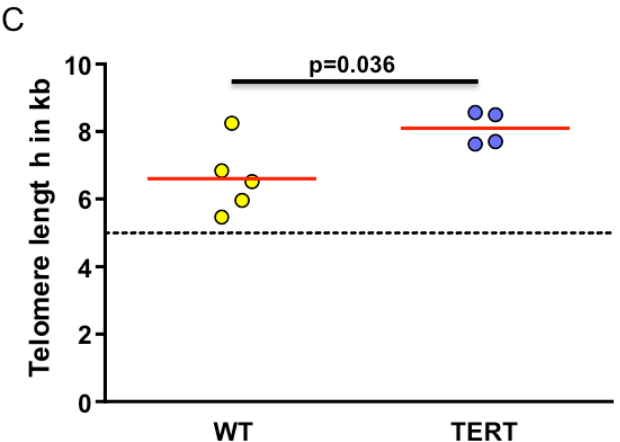
Figure 2. Representative Q-FISH images captured by confocal laser scanning microscopy: ( A ) C228T TERT promoter-mutated myxoid liposarcoma, and ( B ) a TERT promoter wildtype myxoid liposarcoma patient. Magnification 630×. ( C ) Quantification of telomere length after Q-FISH analysis (arbitrary units, a.u.). The dashed line represents 5 kb, the threshold of critical short telomeres.